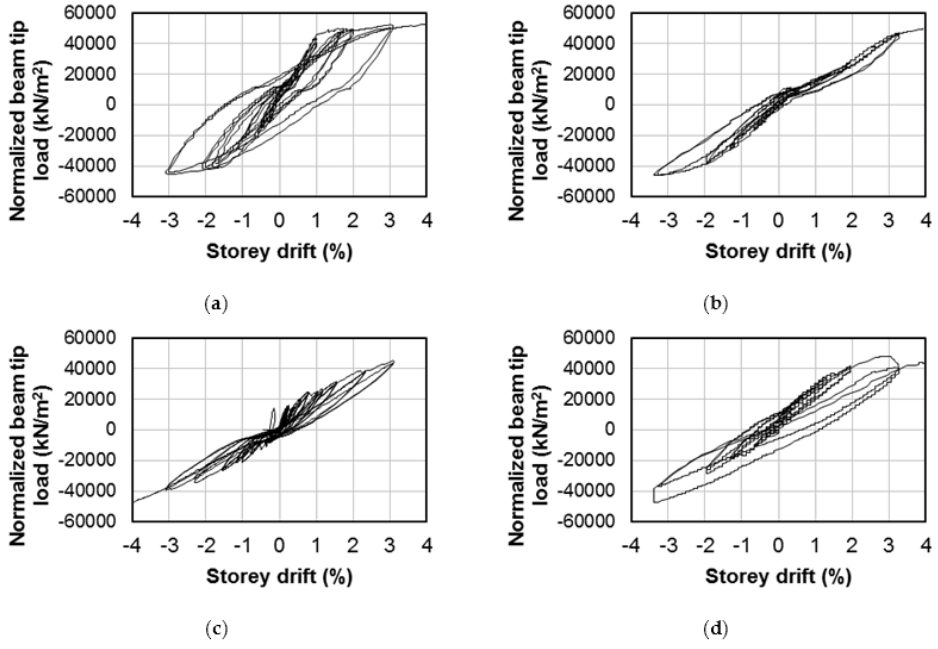
Figure 3. Beam tip load–storey drift relationship of specimen ( a ) JBC1 ( b ) JBC2 ( c ) J4 ( d ) JBC4.